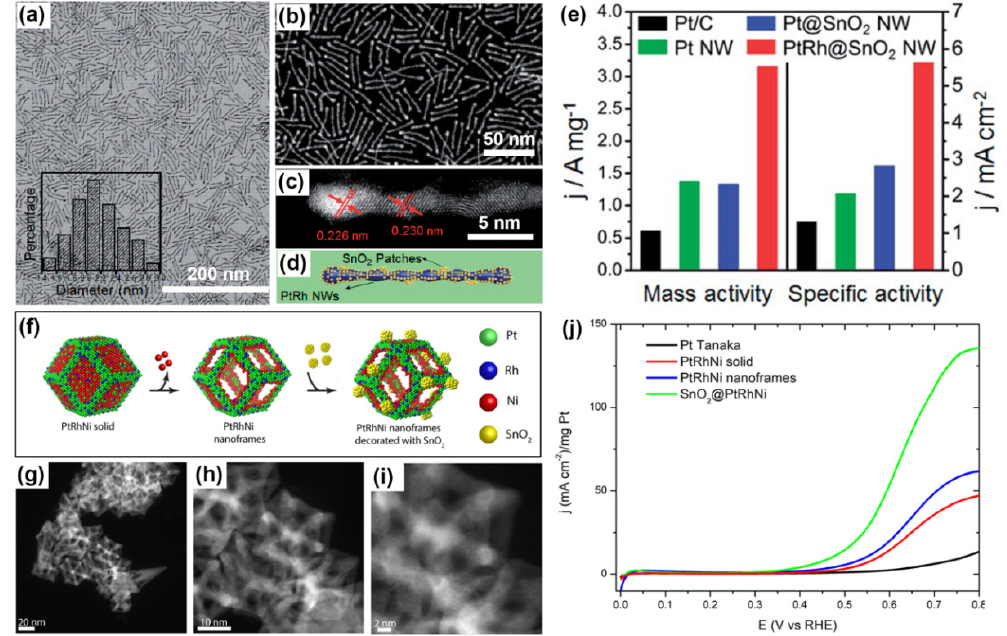
Figure 4. ( a ) TEM image, ( b ) HAADF-STEM (high-angle annular dark-field scanning transmission electron microscopy) image, ( c ) aberration-corrected HAADF-STEM image and ( d ) the structural